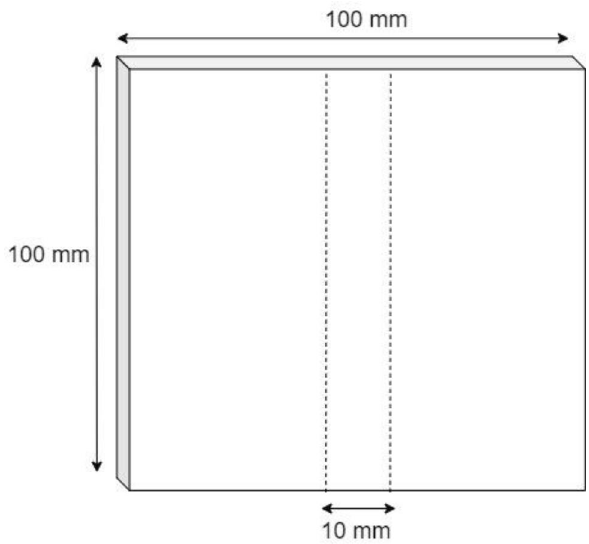
Figure 1. The veneer dimensions used for initial treatment (impregnation of low-molecule phenol and dipping of copper naphthenate), and X-ray scanning sample (dashed